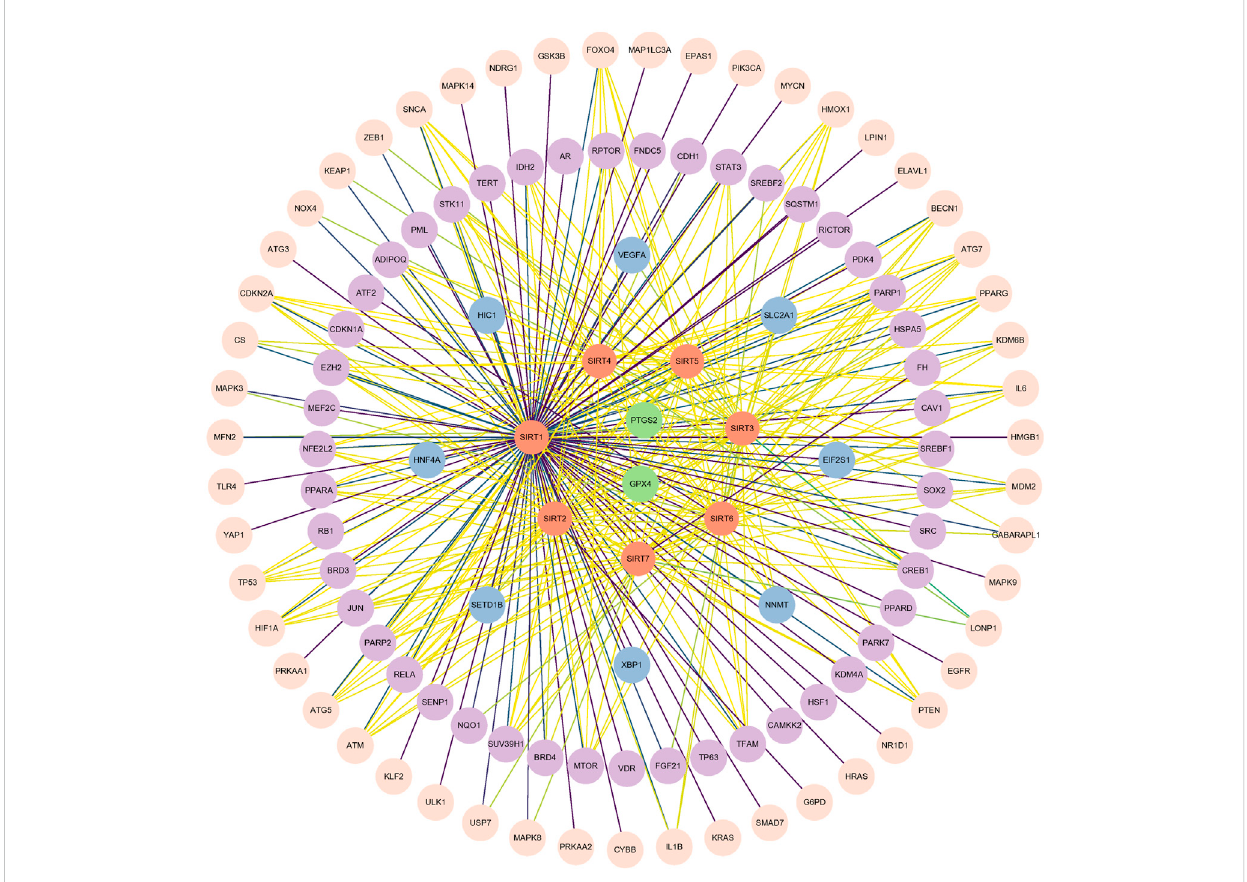
FIGURE 4 The interaction data with humans as species were derived from STRING (http://string-db.org, accessed 17March2023) based on theintersection in the Venn diagram (Figure 3), and this map shows the direct interaction between seven members in the sirtuins family and proteins involved in ferroptosis after data processing with Cytoscape tool. Orange circles denote sirtuins members, and other circles denote ferroptosis-associated genes. The lines (yellow-green-purple) indicate the gradual enhancement of protein-protein